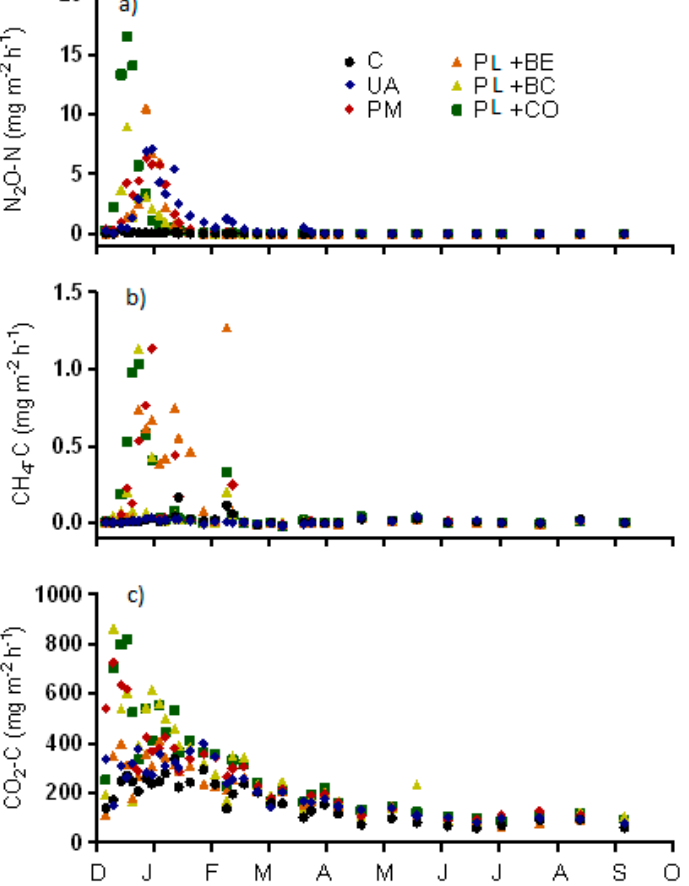
Figure 3. Greenhouse gas fluxes from sugarcane rows at the experimental field site from December 2014 to September 2015. ( a ) Mean N 2 O-N fluxes (mg m − 2 h − 1 ; n = 3), ( b ) mean CH 4 -C fluxes (mg m −